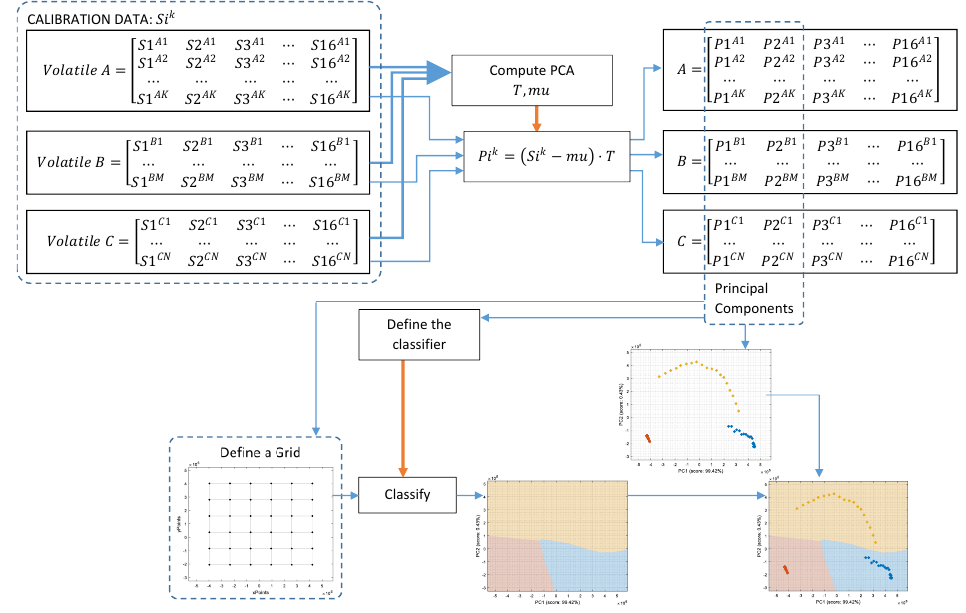
Figure 5. Diagram of the procedure used to compute the class-map representation.